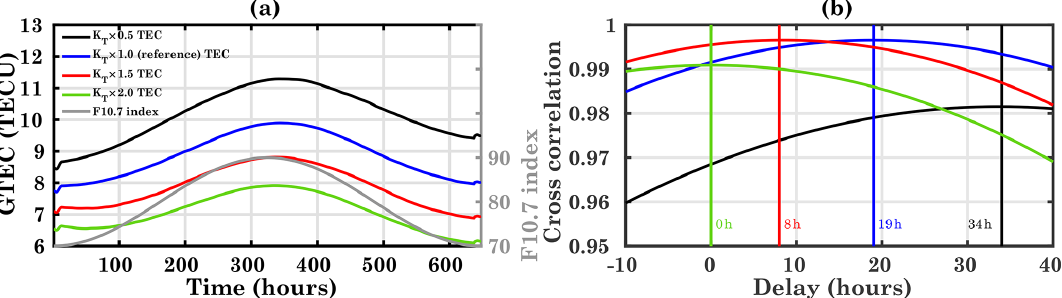
Figure 5. (a) Time series of modeled TEC for the different diffusion conditions K T × 0 . 5, K T × 1 . 0 (reference), K T × 1 . 5, and K T × 2 . 0. F10.7 is added as a gray line. (b) Cross-correlation and the delay between global mean TEC and F10.7 for the different diffusion conditions.